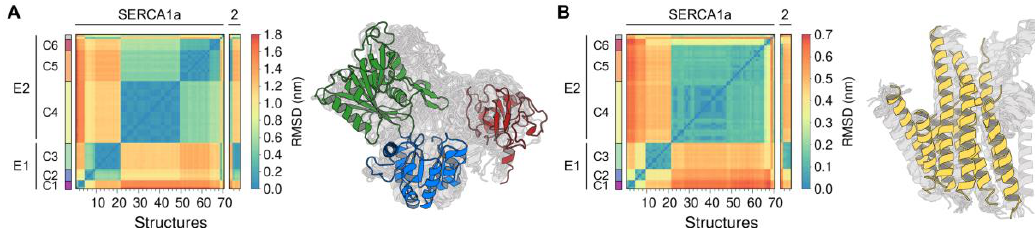
Figure B2. Root-mean-square deviation (RMSD) matrix calculated for the ( A ) Cytosolic domains and ( B ) TM domain of SERCA1a (70 structures), SERCA2a (2 structures), and SERCA2b (2 structures). RMSD-based clustering shows the presence of six major structural clusters, C1 through C6.